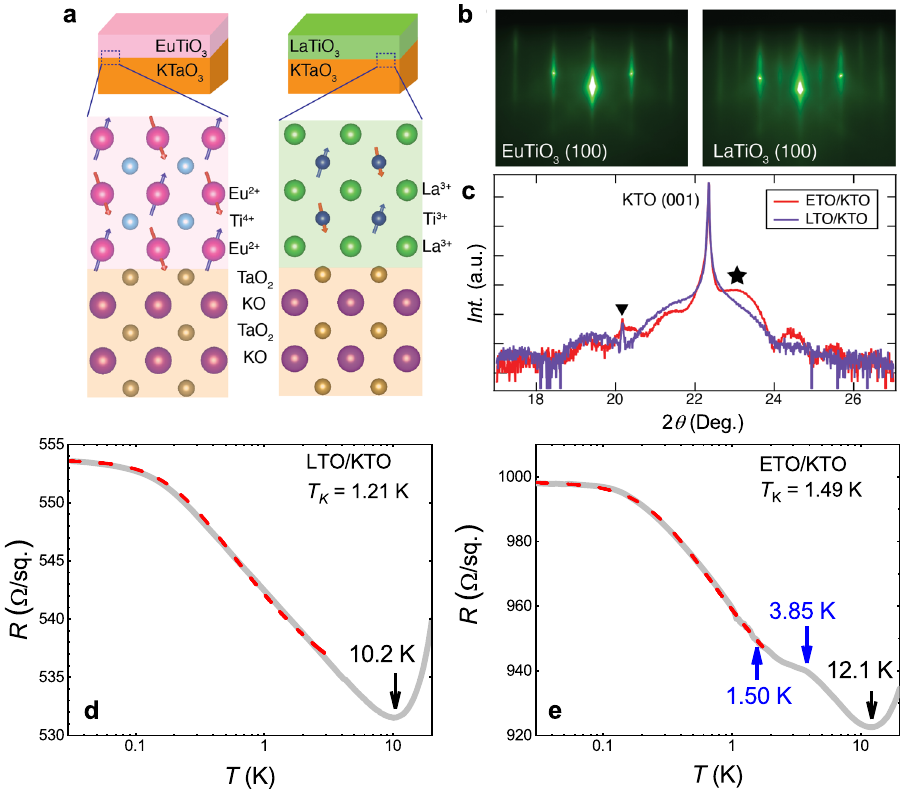
Fig. 1 Structural characterizations and temperature dependence of resistivity for heterostructures of ETO/KTO and LTO/KTO. a Schematic picture of ETO/KTO (left) and LTO/KTO (right) heterostructures and their atomic and antiferromagnetic spin structures (below). The size of spins on the Eu 2 + and Ti 3 + indicates the relative magnitude of magnetic moments (7 μ B /Eu and 0.5 μ B /Ti). b In-situ re fl ection high-energy electron diffraction (RHEED) intensity picture of ETO and LTO after 10 u.c. growth. c XRD scan of 20 u.c. ETO/KTO (red) and 10 u.c. LTO/KTO (purple). The symbol ★ and ▼ indicate the (001) peak of ETO and carbon paste defect, respectively. Temperature dependence of resistivity is plotted in ( d ) for LTO/KTO and in ( e ) for